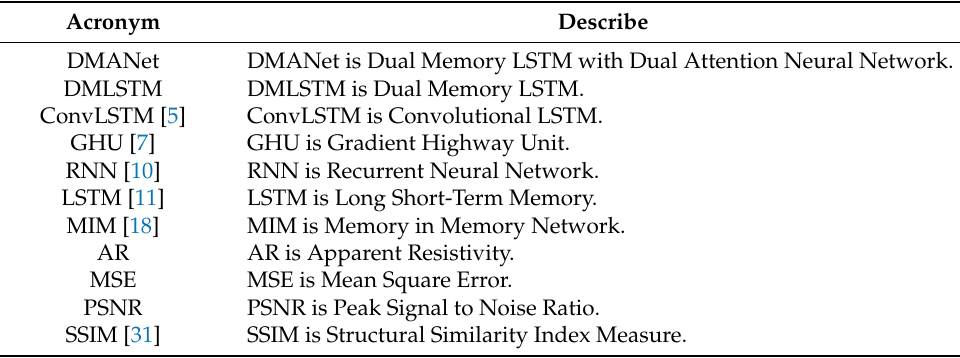
Table 1. The acronyms with a definition about the